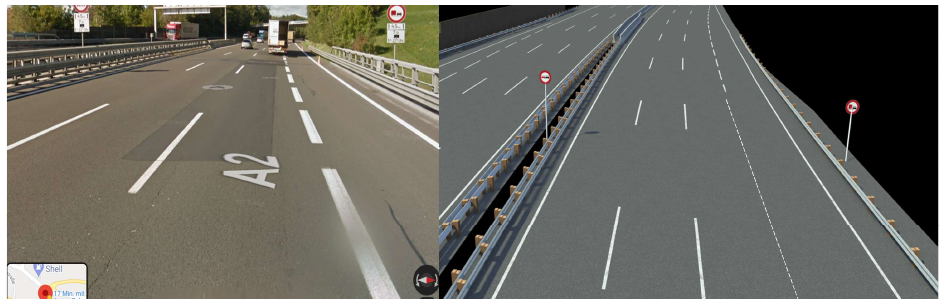
© GoogleMaps Figure 8. Comparison between the real ( left ) and virtual ( right ) environment on a motorway section near Graz,